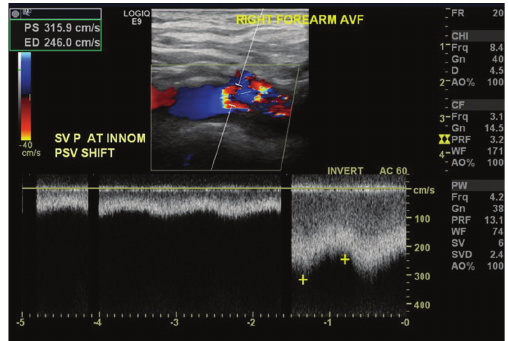
Figure 5: Marked turbulence and a velocity shift at the confluence of the subclavian and innominate veins indicates the presence of outflow stenosis.